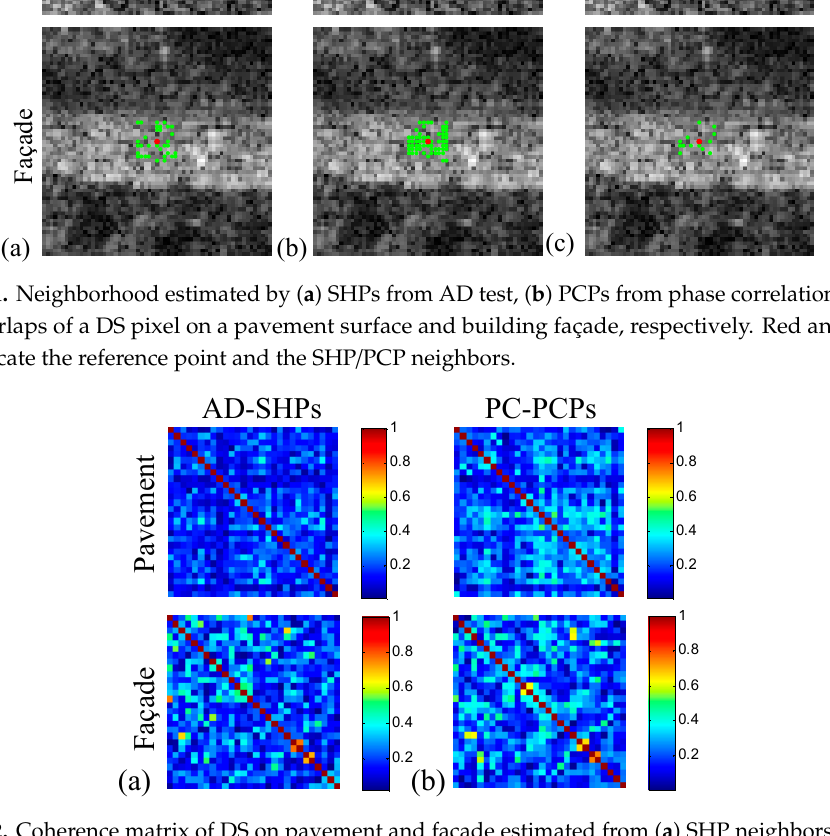
Figure 12. Coherence matrix of DS on pavement and façade estimated from ( a ) SHP neighbors and ( b ) PCP neighbors indicated in Figure 11 .